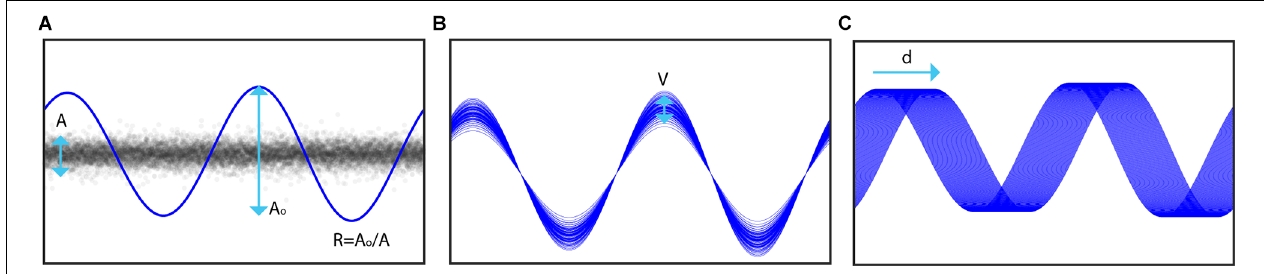
FIGURE 3 | Illustration of simulation components. (A) The root mean squared amplitude ( A o ) of the stimulation model is set relative to that of the neural signal of interest ( A ) according to a target ratio R . (B) The amplitude of each stimulation pulse is varied on a cycle-wise basis where the amplitude of each pulse is sampled from a normal distribution with mean A o and standard deviation V . (C) Inaccuracies in period estimation, drifting sampling rate, and frequency variability are modeled by adding a drift factor d to the stimulation period in the